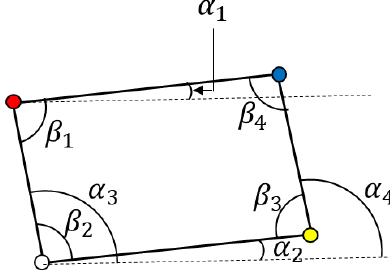
Figure 7. Geometric constraints for road sign HG.